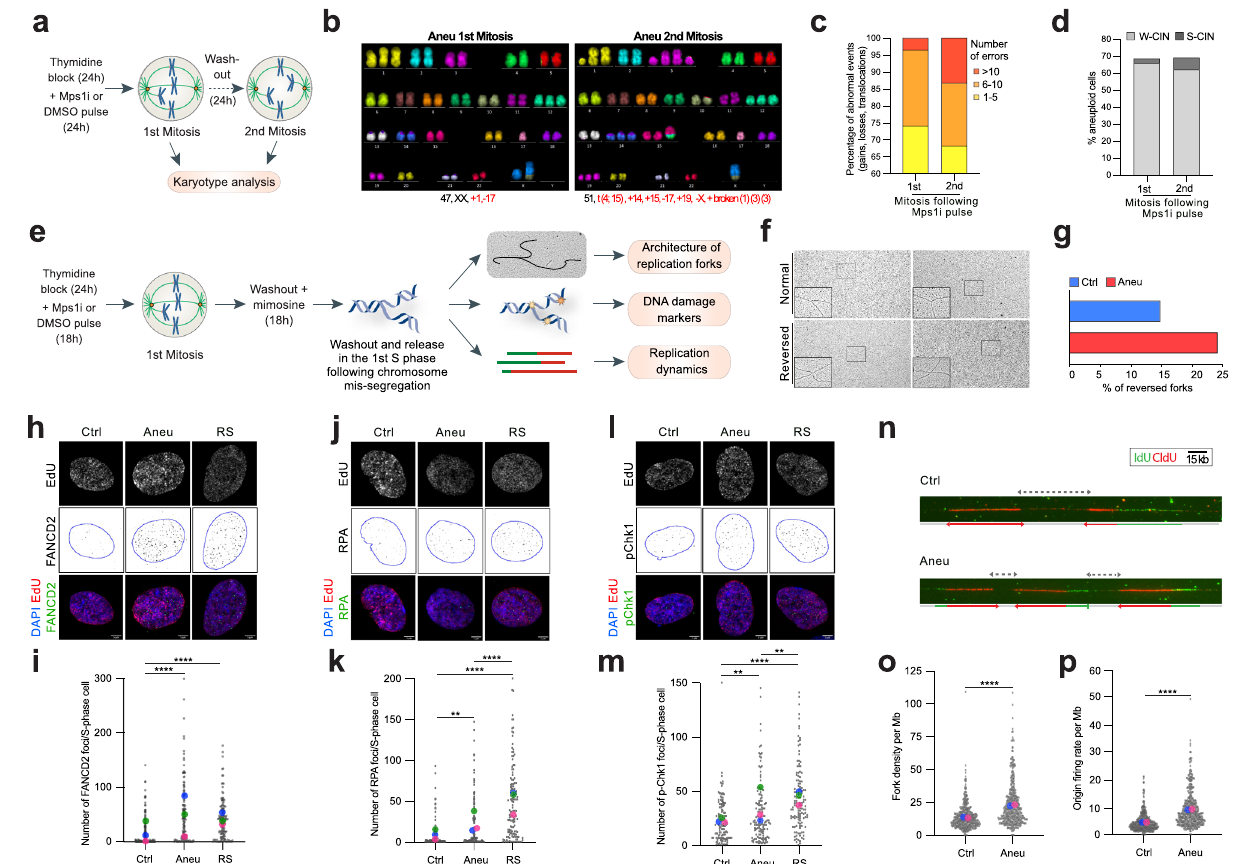
Fig. 1 | Aneuploid cells accumulate increasing genome instability and display higherlevelsofDNAreplicationstressmarkersinS-phase.a Experimentalsetup for the analysis of genome instability of cells obtained from the 1st and the 2nd mitosis.KaryotypeaberrationswereassessedbymFISHanalysis(see “ Methods ” for more details). Representative mFISH images ( b ) of karyotypes obtained from the 1st ( n =68) and the 2nd mitosis ( n =98) in aneuploid cells and relative quanti fi ca- tion ( c ).Y axis shown from 60 to 100%forclarity (from 0 to 60% — and above — cells have 1 – 5 abnormal events, as indicated in key legend). T(10,X) and +12 were excluded from the analysis astheyare clonalinhTERTRPE-1 cells. d Quanti fi cation ofaneuploidcellswitheithernumerical(W-CIN)orstructural(S-CIN)aneuploidyin aneuploid cells obtained from the 1st ( n =68) and the 2nd mitosis ( n =98). e Schematic representation of the experimental approaches used for the study of the 1st S-phase after induction of chromosome missegregation. A short EdU pulse was performed before cell harvest in order to label S-phase cells to be analyzed by immuno fl uorescence. Representative images of normal and reversed replication forks ( f ) analyzed by electron microscopy and quanti fi cation ( g ) of the reversed onesincontrol( n =108)andaneuploid( n =95)cells.Representativeimages( h )and quanti fi cation( i )ofFANCD2fociperS-phasecellincontrol( n =181)andaneuploid ( n =148) cells. **** indicates p <0.0001. Representative images ( j ) and quanti fi ca- tion( k )ofRPAfociperS-phasecellincontrol( n =133)andaneuploid( n